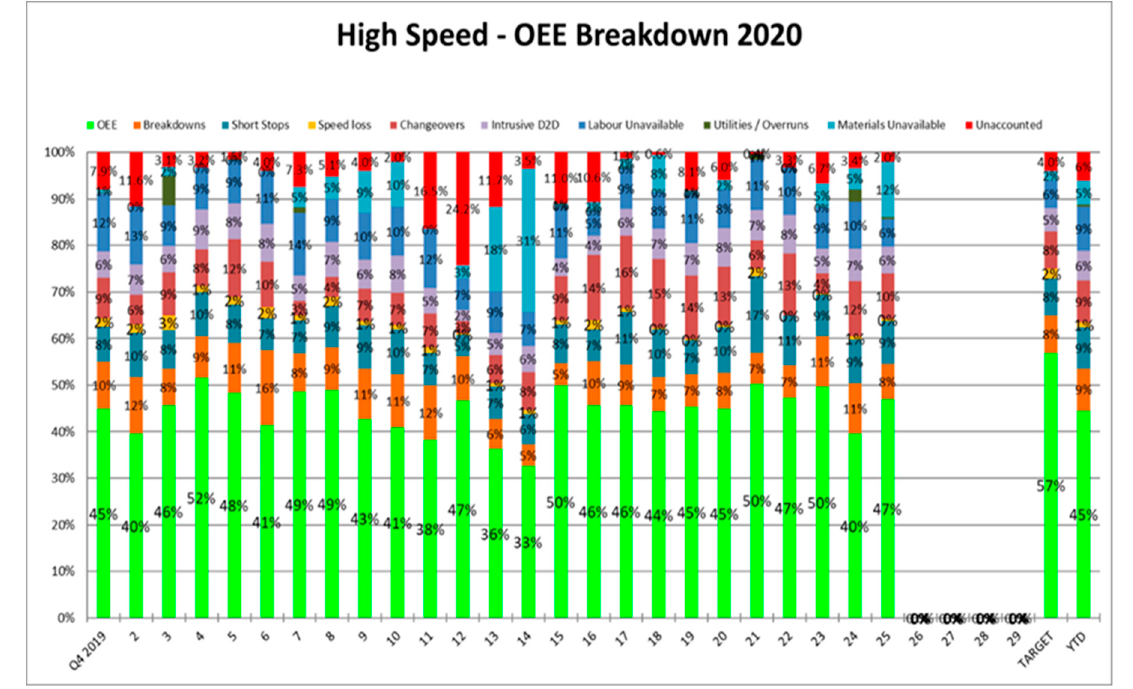
Figure 3. Packaging bar graphs of downtime issues/losses within the Packaging department with % OEE on the x-axis compared against Time (in weeks) on the y-axis. Breakdowns, Short Stops, Changeovers, Labor unavailable, Material Unavailable, Utilities/Overruns, Speed loss, Intrusive stops were all identified as sources of losses in downtime as demonstrated in the bar graph.